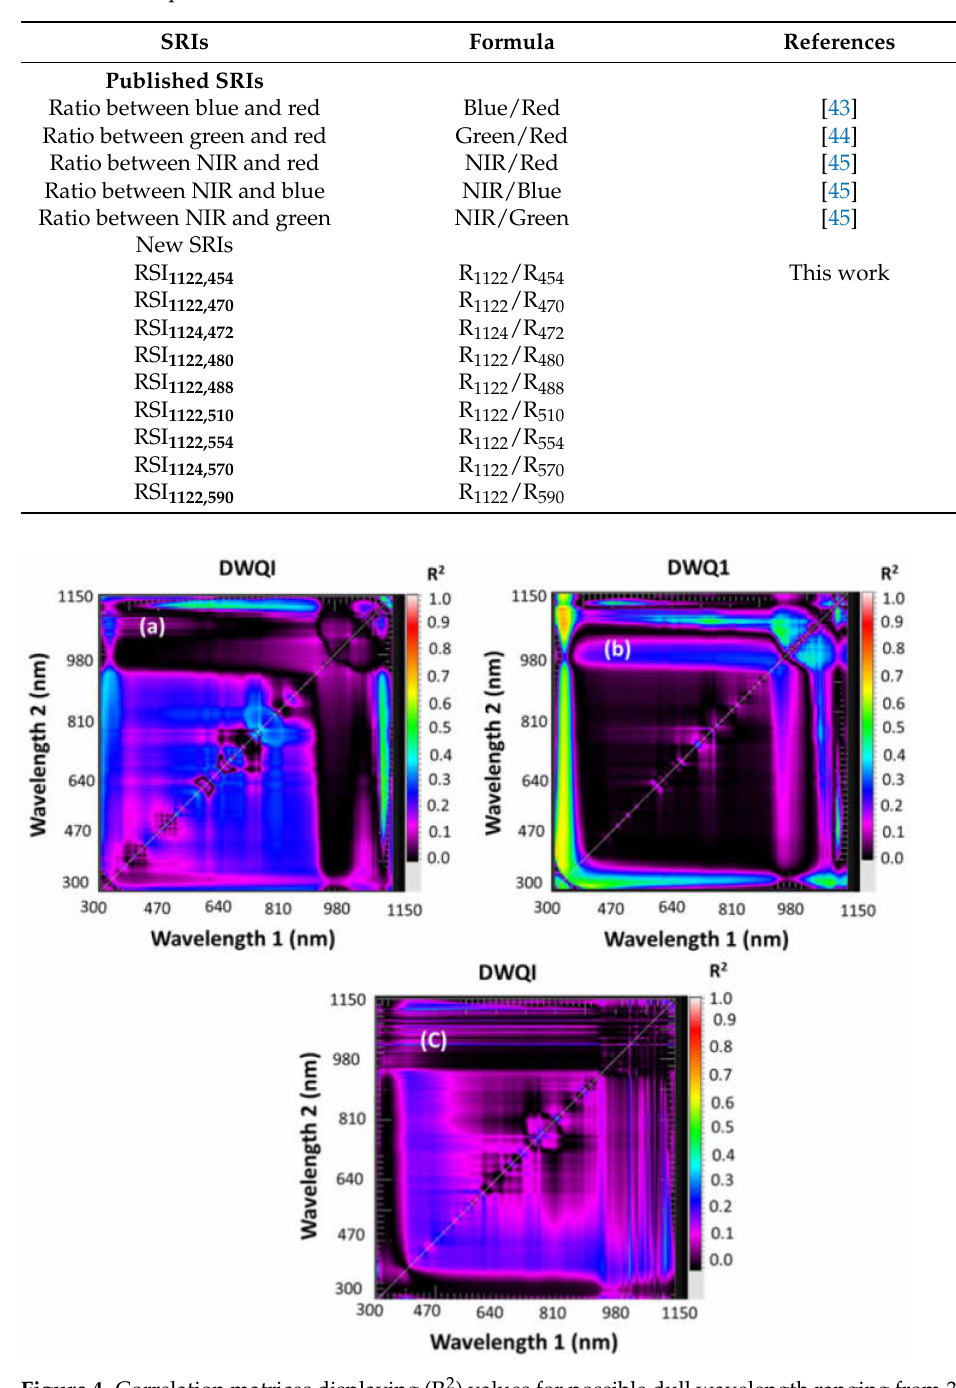
Figure 4. Correlation matrices displaying (R 2 ) values for possible dull wavelength ranging from 302 to 1148 nm with DWQI of three wadies: ( a ) Wadi Marawani, ( b ) Wadi Fatimah, and ( c ) Wadi Qanunah. As indicated in Table 1, a ratio spectral index was calculated using this